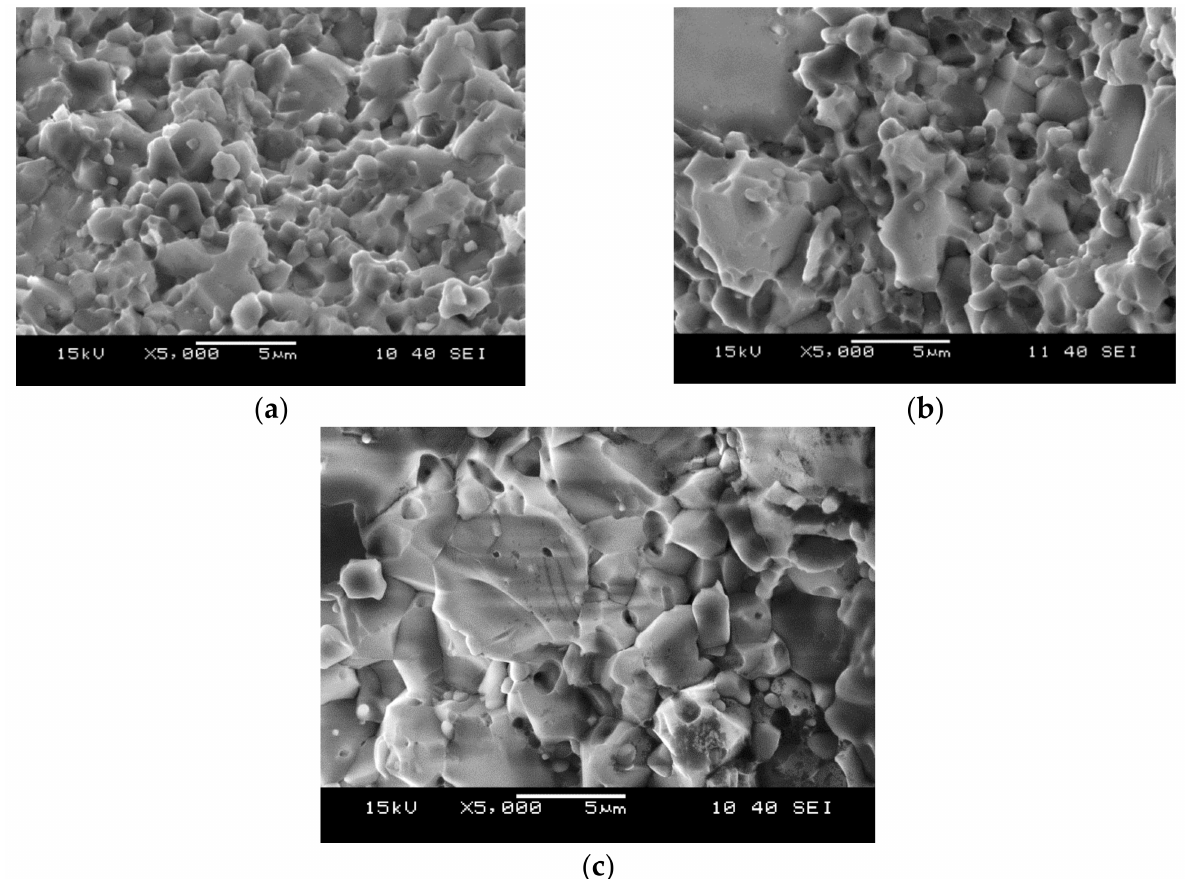
Figure 8. SEM morphologies of the fracture surface of the tested composites (Single-Edge Notched Beam (SENB) sample) sintered at a temperature of 1650 ◦ C: ( a ) TICN5.3; ( b ) TICN5.3n; ( c ) TICN3.3.